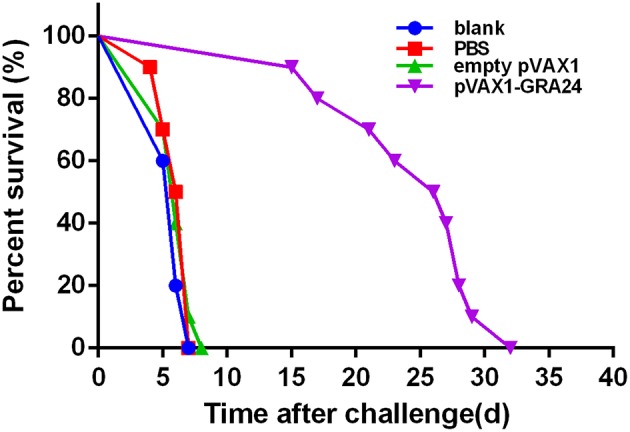
Survival rate of mice immunized with pVAX1-GRA24, pVAX1, PBS, and untreated mice. Each group comprised 10 mice. PBS, phosphate-buffered saline.